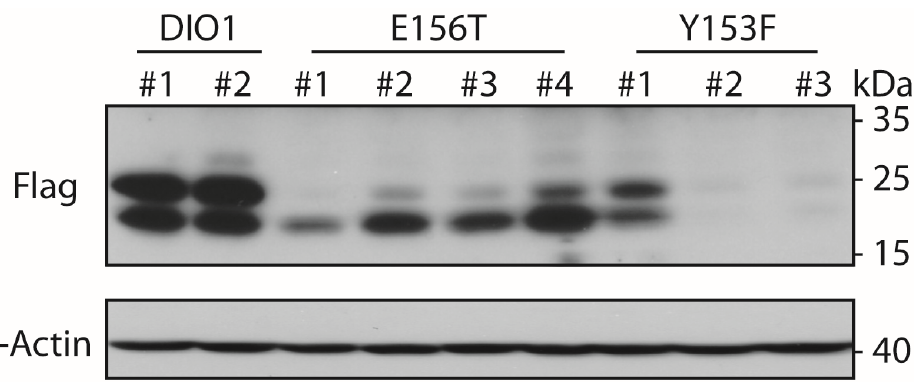
Figure A4. Mass spectrometry of recombinant DIO1 U126C variants. Coverage of the peptide sequence for the different mutants recombinantly expressed in Hi5 cells: ( A ): DIO1 U126C ; ( B ). DIO1 U126C/C124A ; ( C ). DIO1 U126A/C124A . Note the dehydro modifications at positions 124 and 126 in the DIO1 U126C mutant as well as the absence of sequence coverage around the catalytic center for the DIO1 U126C/C124A mu- tant.